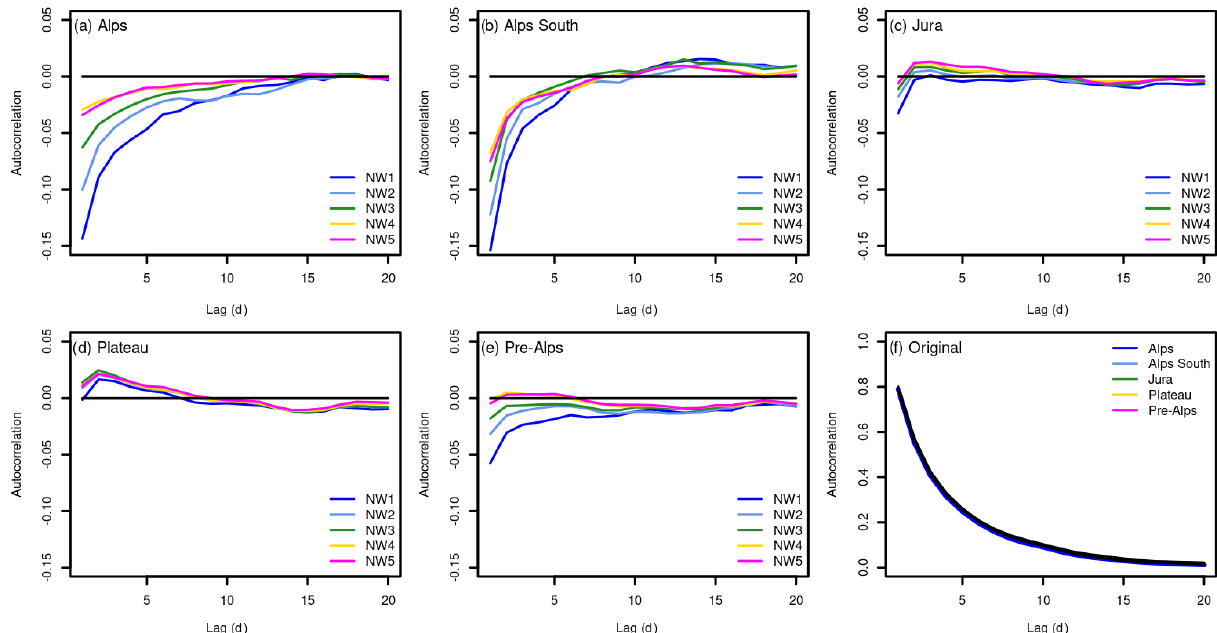
Figure A3. (a–e) Differences between the area mean autocorrelation of the original grid and the reconstructed grid for the five different networks and for five regions of Switzerland. (f) Autocorrelation at lag day 1 to 20 for the original grid and for five regions covering Switzerland. The analysis is performed on the cross-validation results for the period of 1961 to 2020. See Fig. 1 for the network set-ups. The regions correspond to the major regions used for the national climate scenarios (NCCS, 2018).